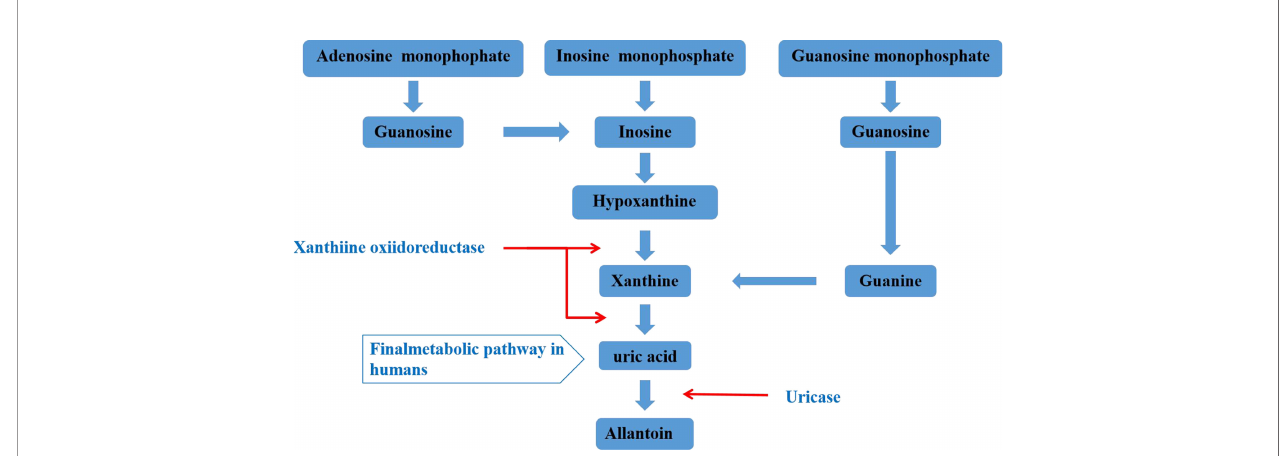
FIGURE 1 | Metabolism of uric